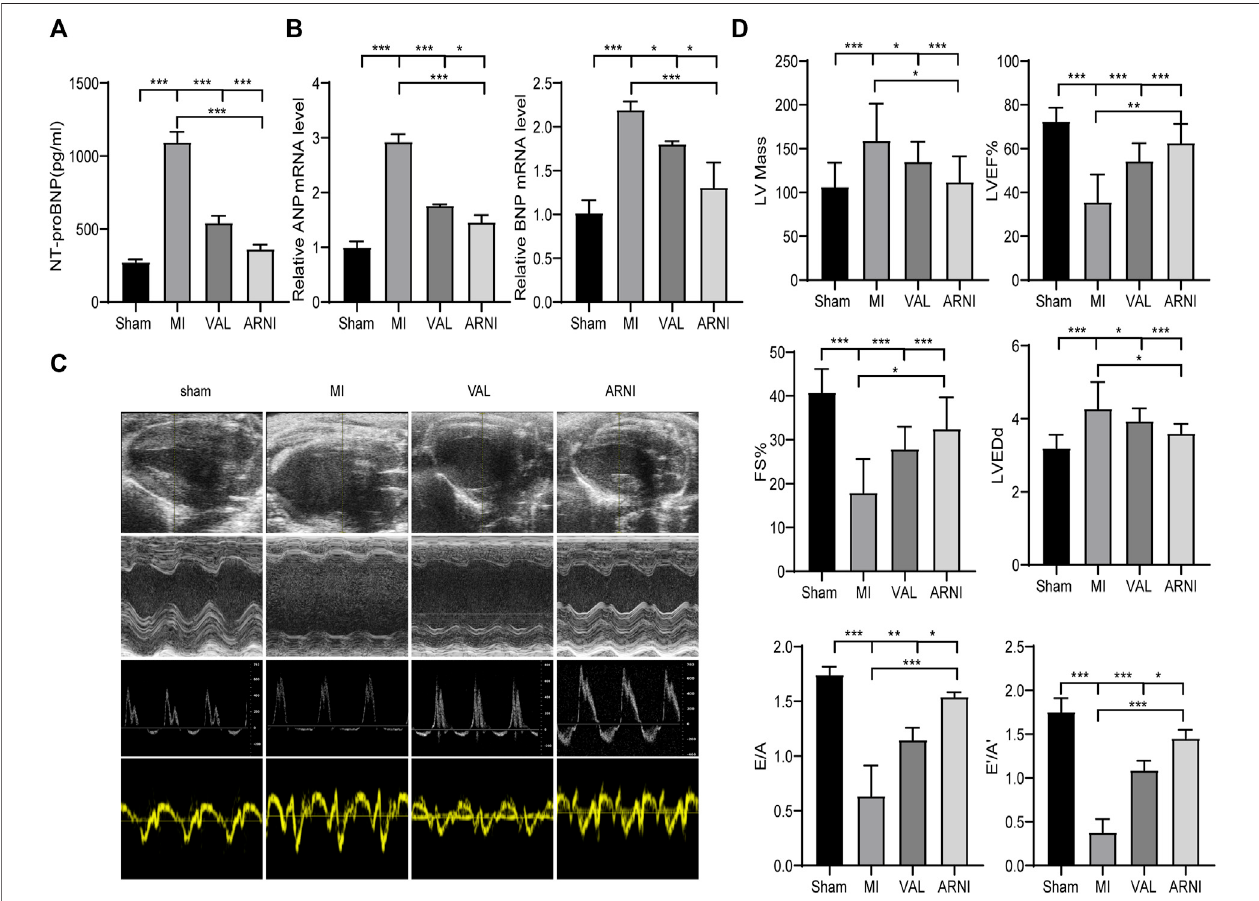
FIGURE 2 | ARNI alleviates cardiac dysfunction in mice with myocardial infarction. (A) Serum NT-proBNP concentration. (B) Relative mRNA fold changes of ANP and BNP . (C) . The 1st row:Representative 2D echocardiograms. The 2nd row: Representative M-mode echocardiograms. The 3rd row: Representative pulse-wave doppler echocardiograms of mitral in fl ow. The 4th row: Representative tissue doppler echocardiograms. (D) Left ventricular mass, LV ejection fraction (LVEF%), fractional shortening (FS), left ventricular end-diastolic dimension (LVEDd), early-to-late mitral fl ow (E/A), and diastolic velocity ratio (E ’ /A ’ ). Each group n (cid:1) 8.* p < 0.01,** p < 0.05, *** p <